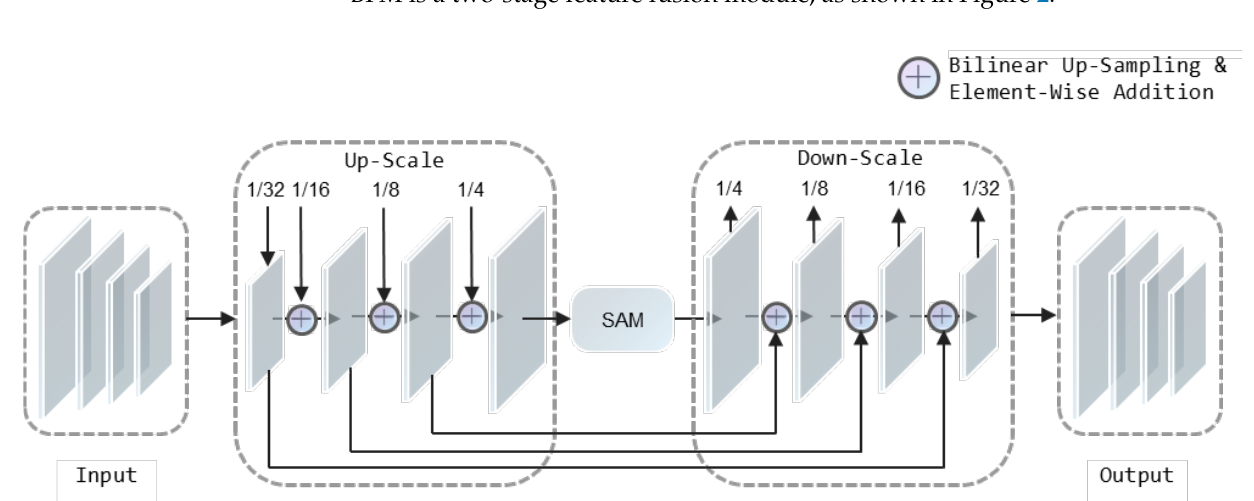
Figure 2. It shows the details of BFM. The input to this module is four-scale feature maps extracted by the backbone network starting from Conv2. The output is the enhanced multi-scale feature maps. “+” is the element -wise addition after up - sampling to the same scale.